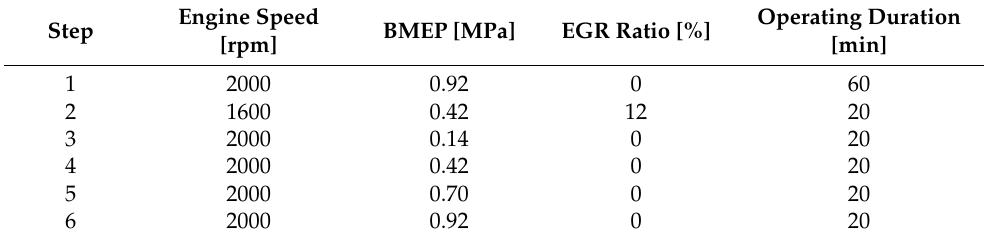
Table 3. Experimental procedure of BET